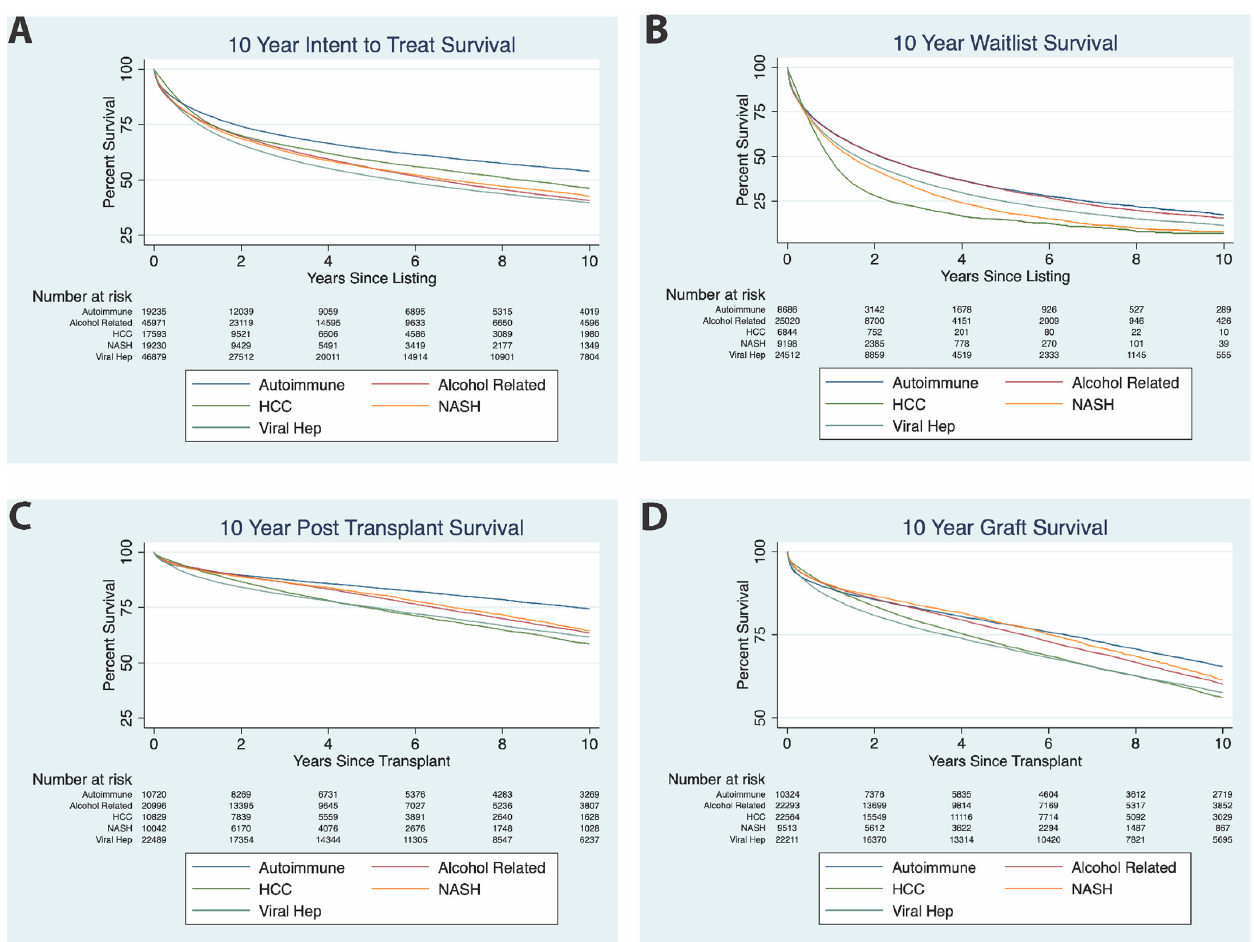
Figure 2. ITT Survival, Waitlist Survival, Post-Transplant Survival, and Graft Survival for Liver Transplantation HCC, ALD, Autoimmune Conditions, Viral Hepatitis, and NASH. ( A ) ITT Survival, all AutoD curves are significantly different from other curves ( p -value < 0.001, log rank test). ( B ) Waitlist Survival, all AutoD curves are significantly different from other curves ( p -value < 0.001, log rank test) with exception of ALD ( p -value = 0.1056, log rank test). ( C ) Post-transplant survival, all AutoD curves are significantly different from other curve ( p -value < 0.001, log rank test). ( D ) Graft survival, all AutoD curves are significantly different from each other ( p -value < 0.001, log rank test, NASH ( p = 0.0345, log rank test).